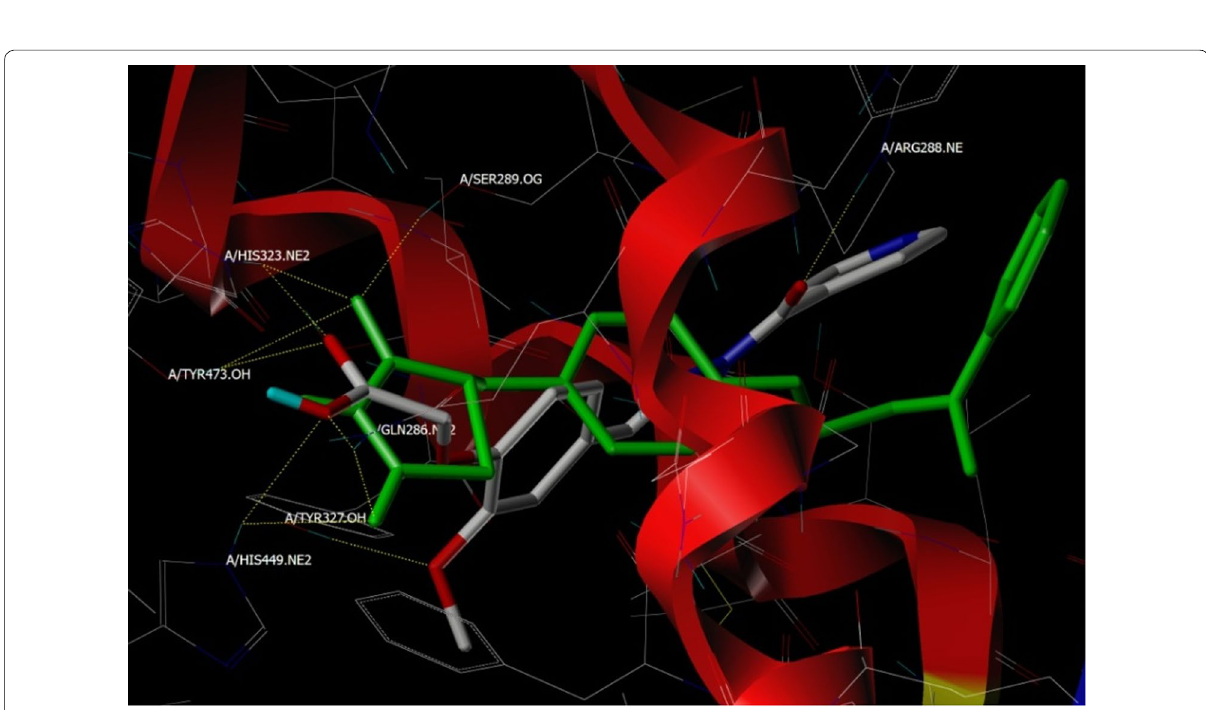
Fig. 5 Overlap of pioglitazone (green color) and CPD20 (atom type color) at the binding site of PPARγ showing comparable hydrogen bonding (yellow dots) interactions with amino acids; His 323, Tyr 473, Tyr 327, Gln 286, His 449 and Arg 288 at the binding